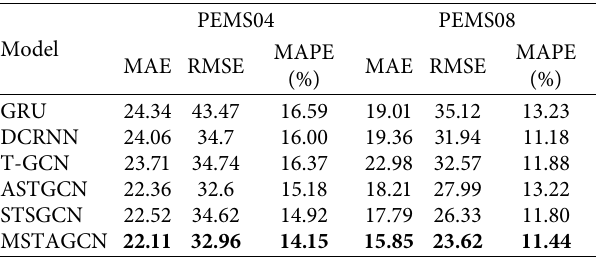
Table 2: Performance comparison of different models of traffic flow